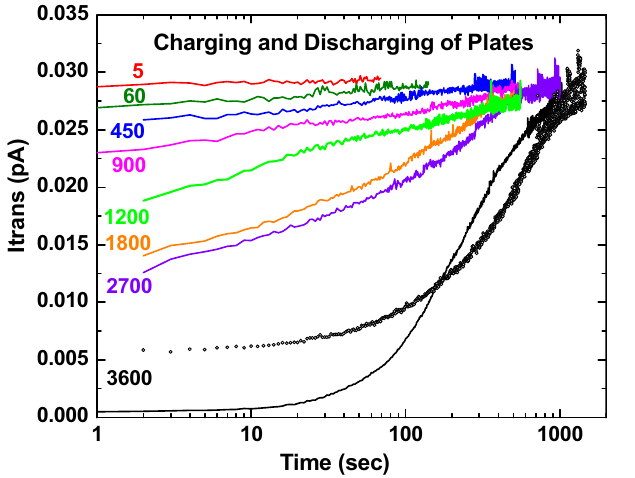
Figure 4. Transmitted beam intensity as a function of time following various plate discharge times in seconds. The solid black curve shows the initial measurement in the sequential series with the open black circles showing a repeat measurement on the following day.